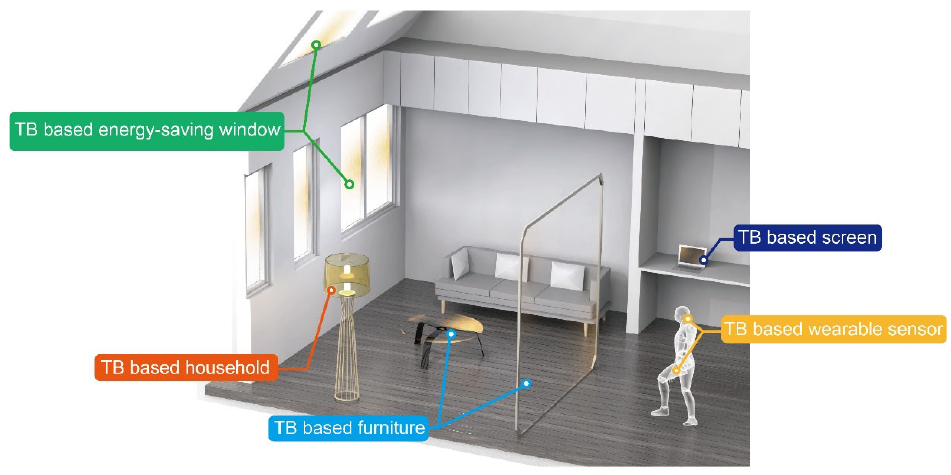
Figure 9. Design of a future integrated application of TB.